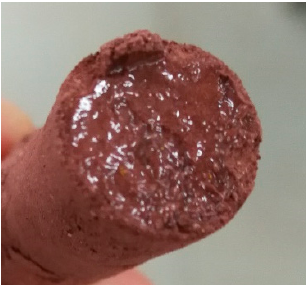
Figure 6. Accumulation of the polymer emulsion on the surface.